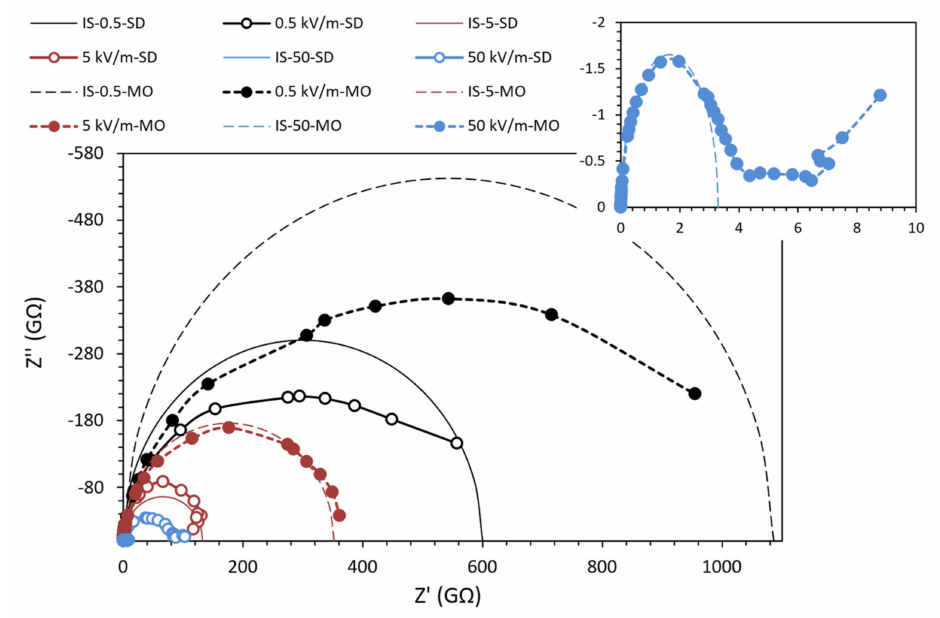
Figure 14. Cole-Cole diagram of the complex impedance Z* of the investigated